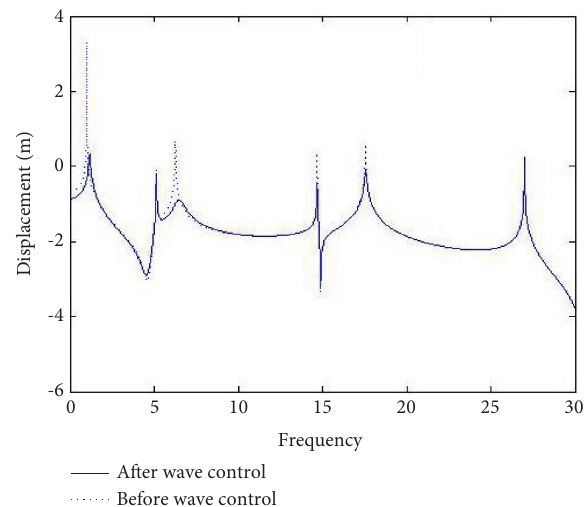
Figure 4: Frequency response before and after wave control.